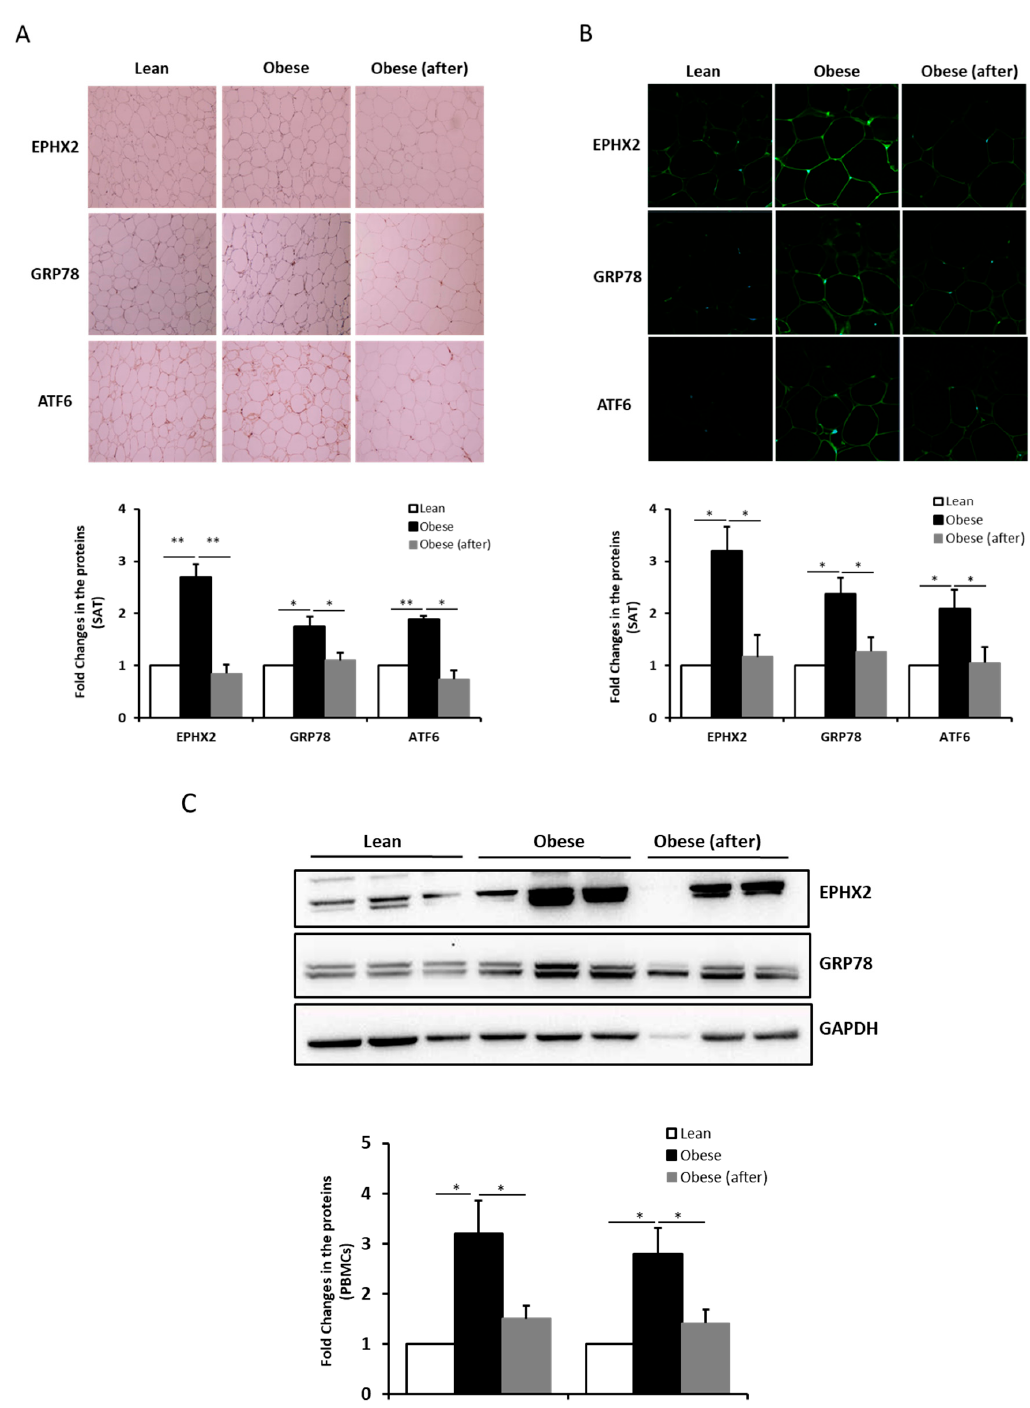
Figure 2. EPHX2 protein levels in SAT and PBMCs from human subjects. Representative immunohistochemical ( A ) and confocal immunofluorescence ( B ) images illustrating EPHX2, GRP78, and ATF6 expression and localization in SAT from lean, obese before exercise, and obese after exercise group ( n = 5 each). Staining quantification of SAT was performed as detailed in Materials and Methods; data are presented as fold changes compared to the normal-weight group. ( C ) Protein expression of EPHX2, GRP78, and ATF6 in PBMCs according to groups (at least n = 9 each). Protein levels were measured by Western Blotting. GAPDH was used as an internal control for normalization. Data are presented as fold changes compared to the lean participants. * p < 0.05; ** p < 0.01.